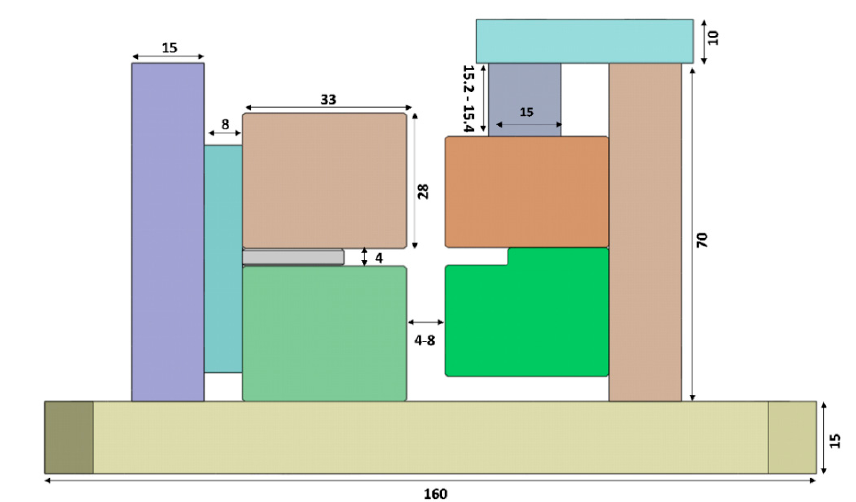
Figure 7. Leakage test rig dimensions (the units are in mm).